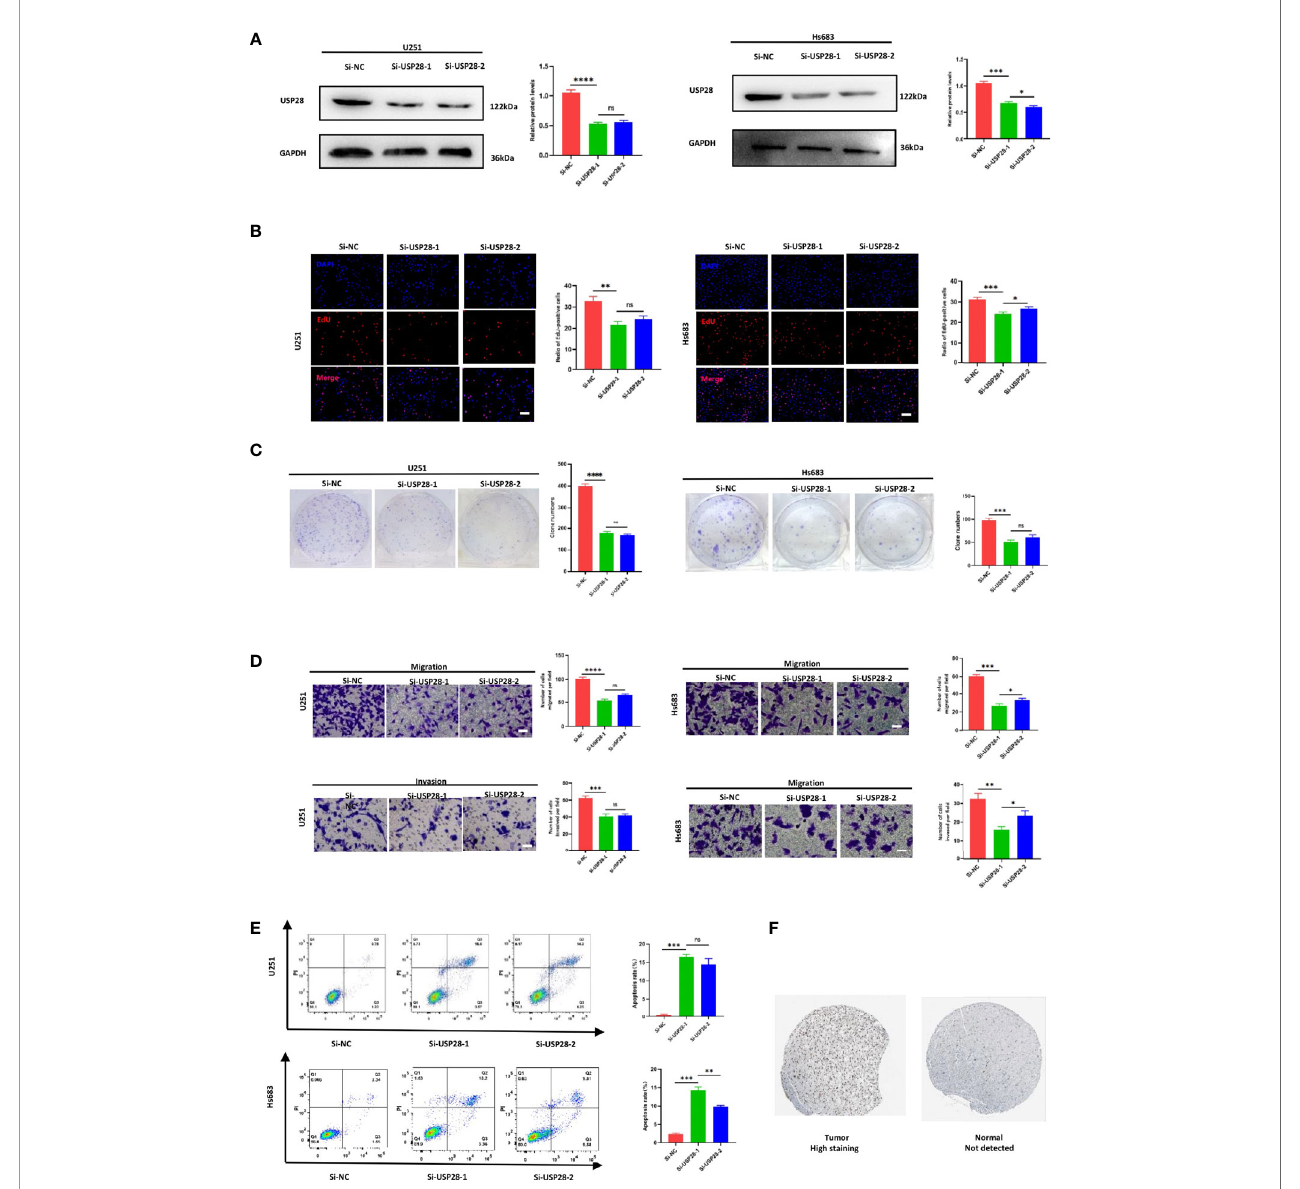
FIGURE 8 | Knockdown of USP28 suppressed the proliferation, migration, invasion and increased cell apoptosis rate of U251 and Hs 683 cells in vitro . (A) Western blot analysis to examine the ef fi ciency of the USP28 knockdown. (B) Proliferation ability in USP28 knockdown U251 and Hs 683 cells by EdU staining. (C) Colony- forming abilities in USP28 knockdown U251 and Hs 683 cells by clonogenic assays. (D) Transwell assays to detect the migration and invasive capacities in USP28 knockdown U251 and Hs 683 cells. (E) Flow cytometry to analyze the apoptosis of U251 and Hs 683 cells. (F) USP28 expression in glioma tissues. Magni fi cation, × 200 (B, D) . Scale bar, 100 m m (B, D) . *, **, ***, **** and ns mean p < 0.05, p < 0.01, p < 0.001, p < 0.0001 and insigni fi cance in statistics, respectively. Data are shown as mean ± SD of at least three independent